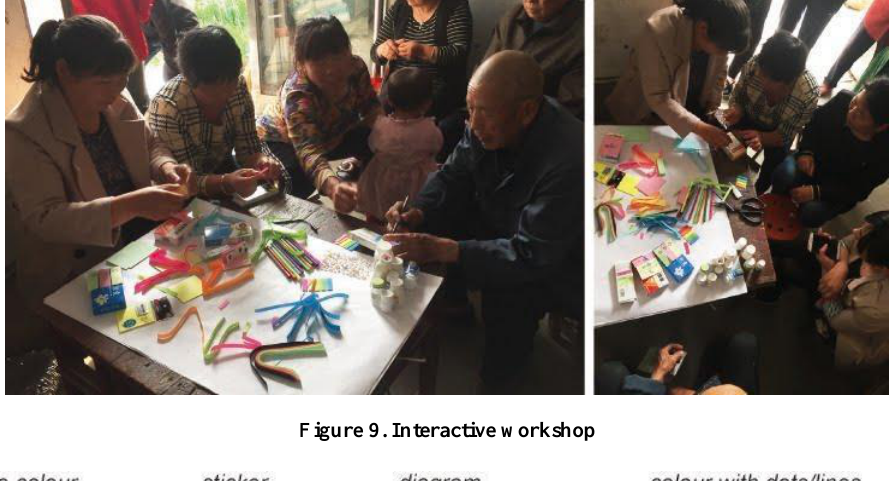
Figure 8. Interactive brainstorming